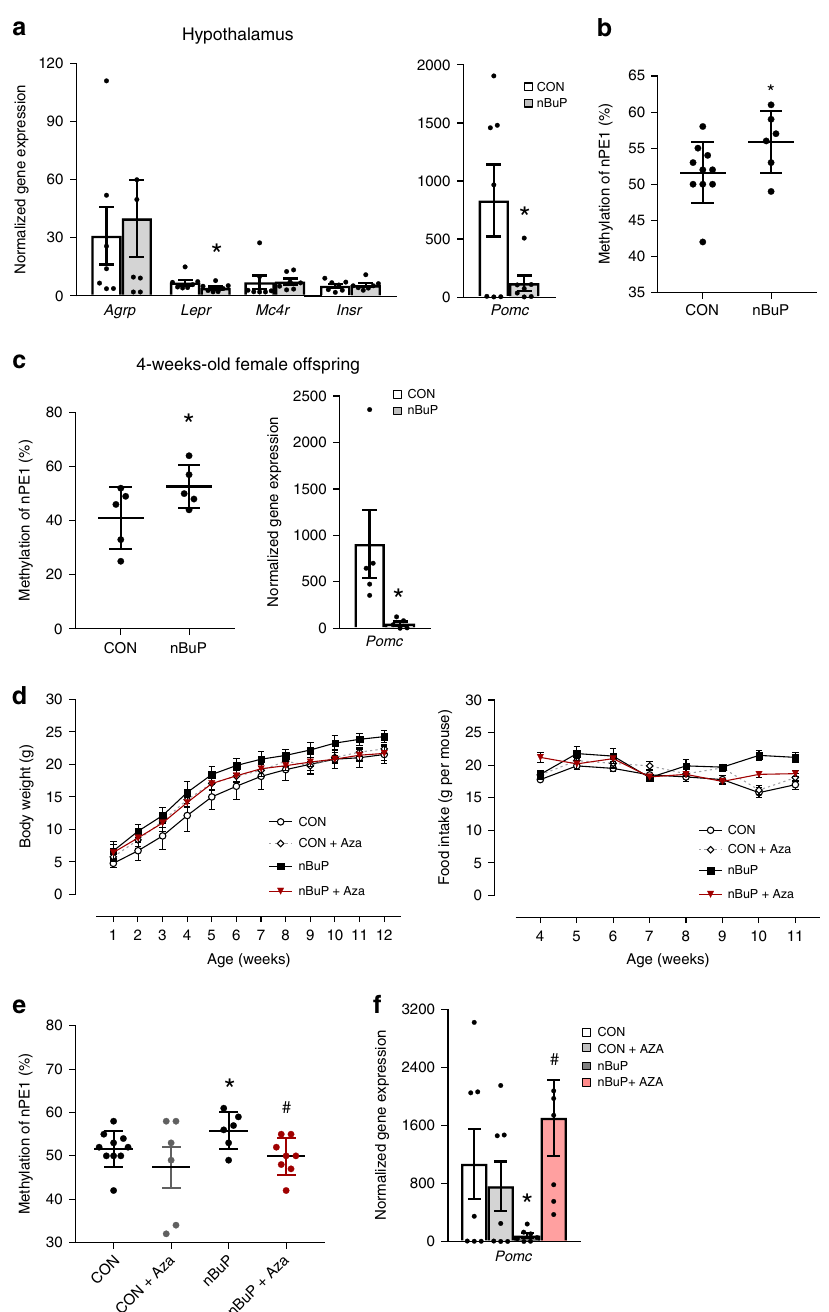
Fig. 4 Perinatal nBuP exposure reduced pro-opiomelanocortin (pomc) expression and induced a DNA hypermethylation of nPE1. a Expression levels of genes important for the neuronal regulation of satiety and hunger ( n = 7) and ( b ) DNA methylation of the neuronal POMC enhancer nPE1 (chr12:3941750- 3942350, CON: n = 10, nBuP: n = 6) were analysed in the hypothalamus of the 12-week-old female offspring. Values for DNA methylation in both groups are pictured for CpG1 (cg3942264). c DNA Methylation of nPE1 and pomc gene expression from the 4-weeks-old female offspring of nBuP-exposed dams are shown (n = 5). d After treatment of F1 mice with the DNA methyl-transferase inhibitor Aza body weight development (CON: n = 18, CON + Aza: n = 12, nBuP: n = 16, nBuP + Aza: n = 8) and food intake (CON: n = 10, CON + Aza: n = 9, nBuP: n = 6, nBuP + Aza: n = 8) were evaluated. e nPE1 methylation (CON: n = 10, CON + Aza: n = 6, nBuP: n = 6, nBuP + Aza: n = 8) and ( f ) pomc gene expression ( n = 7) was measured in Aza-treated female offspring from nBuP-exposed dams. Data are expressed as mean ± SEM, * P < 0.05 for nBuP vs. CON, # P < 0.05 for nBuP + Aza vs. nBuP, Student ’ s unpaired t -test. For longitudinal analysis ( d ) GEE models were applied (see Supplementary Table 5). Source data are provided as a Source Data fi